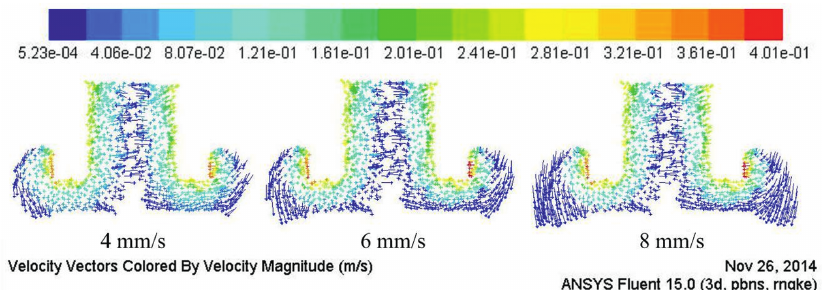
Figure 17: High-speed areas using different refilling